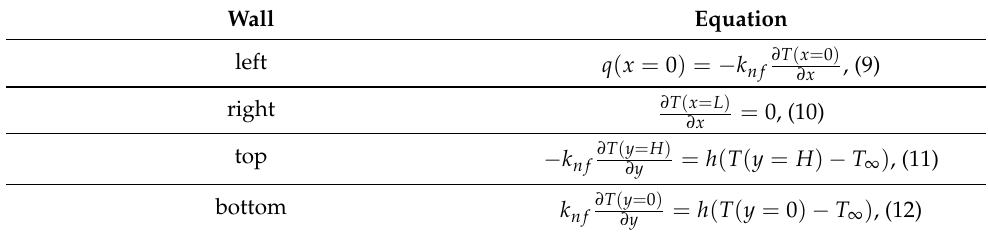
Table 3. Thermal boundary conditions of fluid